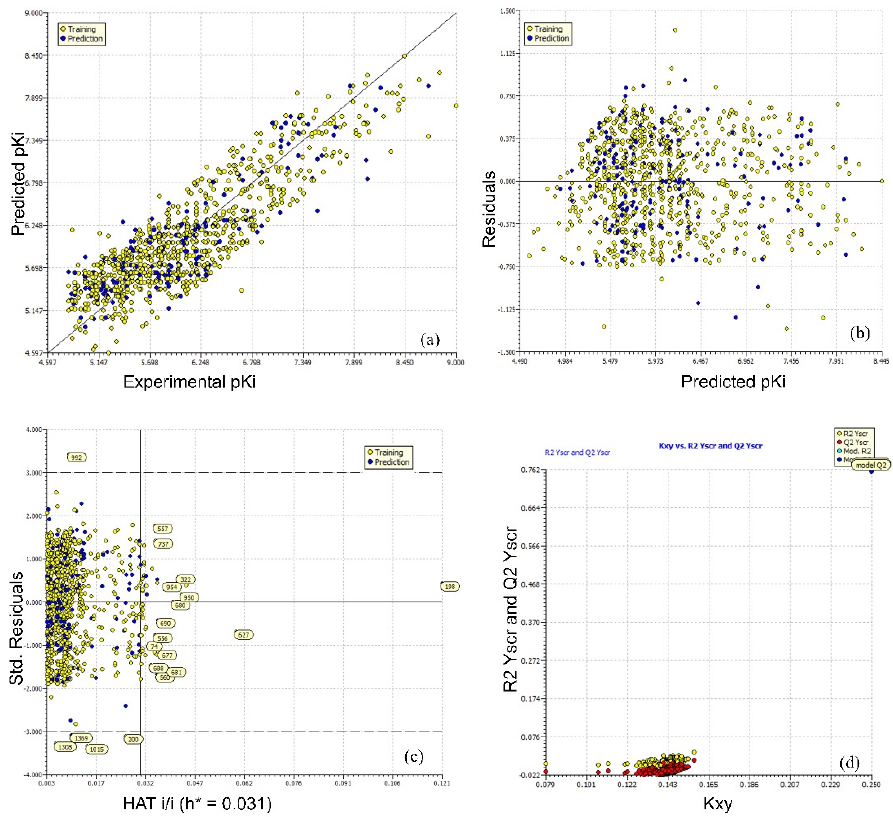
Figure 3. Different graphs associated with the model: ( a ) experimental vs. predicted pIC 50 (the solid line represents the regression line); ( b ) experimental vs. residuals values; ( c ) Williams plot for applicability domain (the vertical solid line represents h * = 0.031 and horizontal dashed lines represent the upper and lower boundaries for standard residuals); ( d ) Y-randomization.